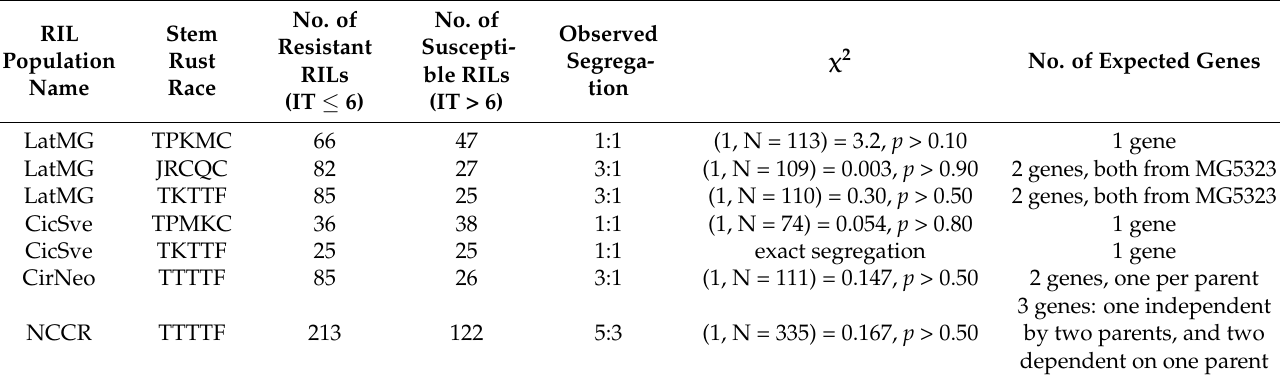
Table 1. Chi-square tests for segregation of stem rust reaction in four recombinant inbred line populations of durum wheat.